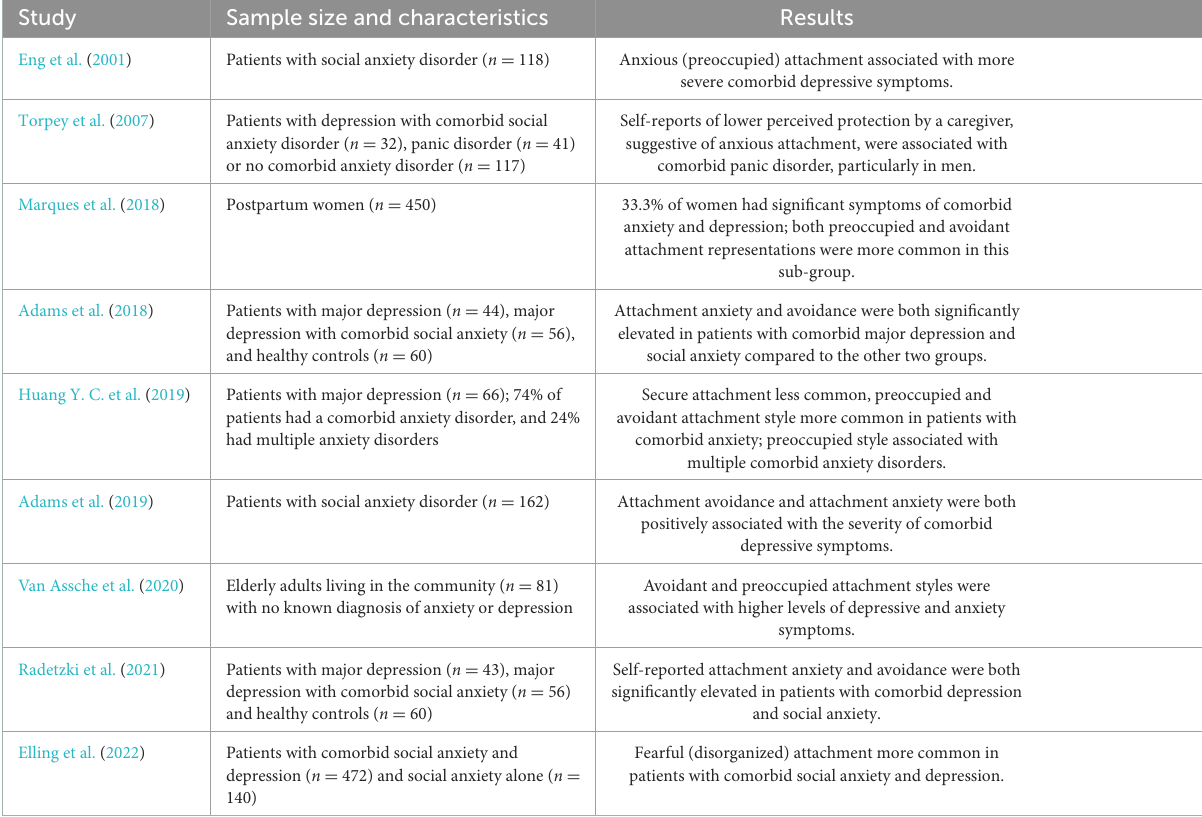
TABLE 2 Studies examining attachment patterns or styles in patients with comorbid depression and anxiety. Study Sample size and characteristics